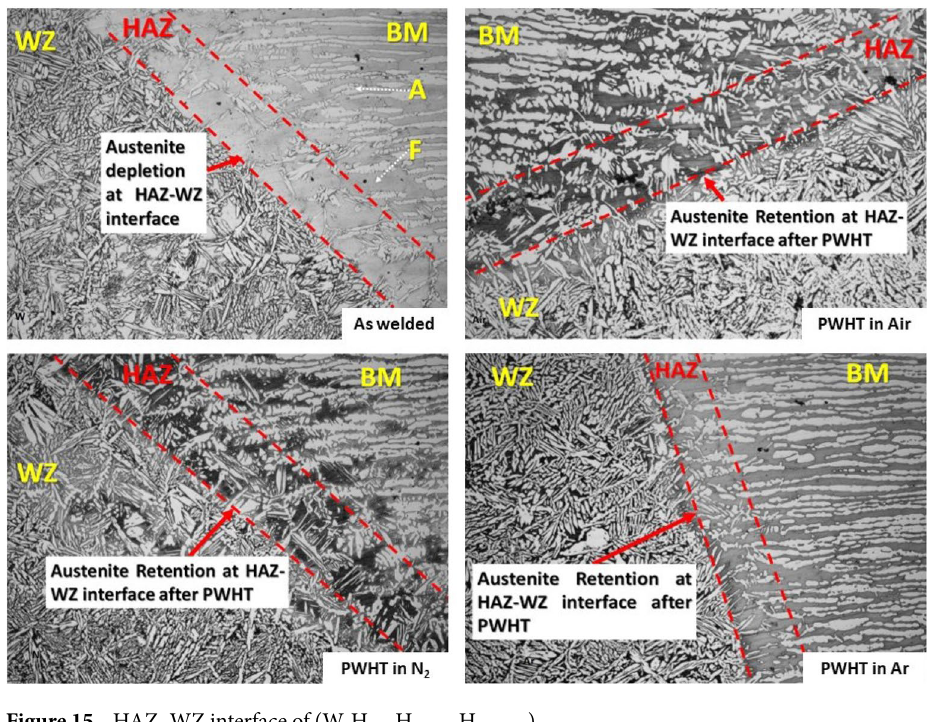
Figure 15. HAZ–WZ interface of (W, H Air , H Argon , H Nitrogen ).